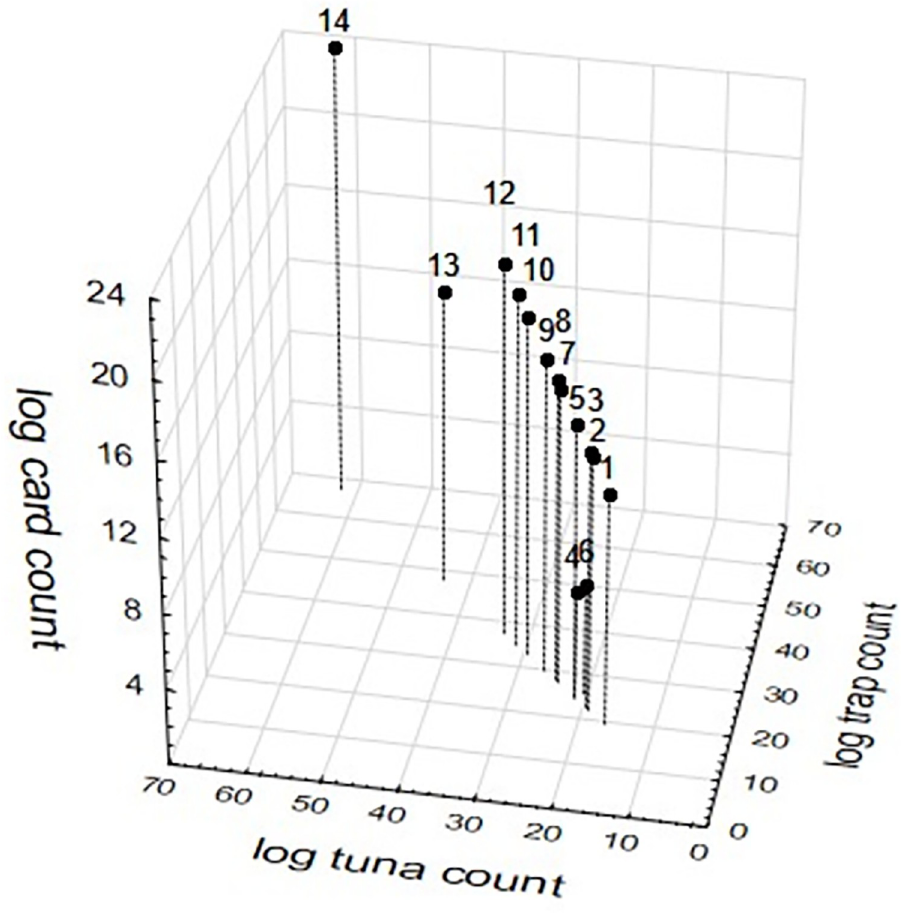
Fig 4. 3D scatterplot of standardised highest yellow crazy ant abundance among fourteen studies as calculated by the relationships between the three sampling methods of card counts, pitfall trapping and tuna lures using sample-based log(x+1)-transformed pooled data. Studies are: 1) [30]; 2) [31] New Caledonia site; 3) [31] Australia site; 4) [21]; 5) [32]; 6) this study; 7) [33]; 8) [34] 9) [17]; 10) [35]; 11) [36]; 12) [37]; 13) [38]; and 14)